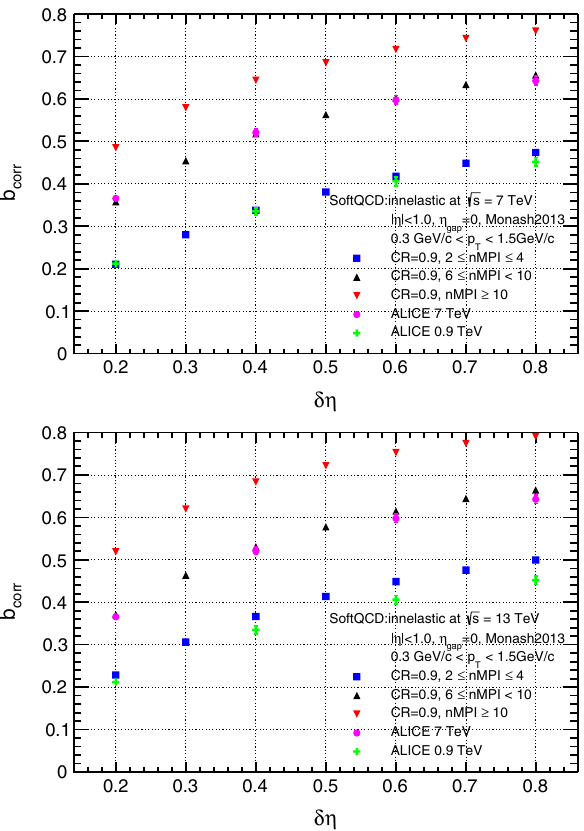
Fig. 8 The correlation factor in terms of ranges of MPI and CR for √ s = 7 TeV (upper) and 13 TeV (bottom), compared p + p collision at to ALICE data at 0.9 and 7